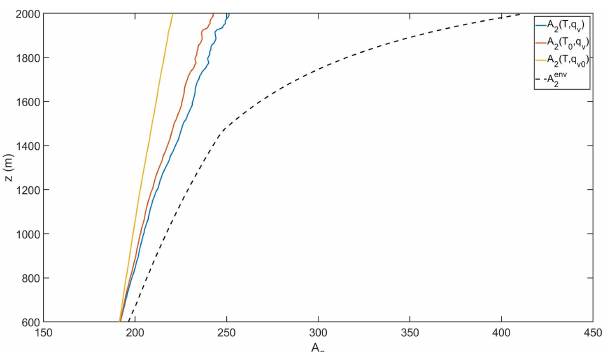
Figure 4. The sensitivity of the A 2 profile to temperature and hu- midity. The growth rate of LWC ad depends on the ratio of A 1 Eq. 6). LWC ad changes with height depend mostly on A 2 , since A 1 exhibits little sensitivity. The blue curve is the true profile of A 2 . Red and yellow A 2 profiles are calculated using constant temper- ature and humidity, respectively, and the dashed black line is the profile obtained using the environmental